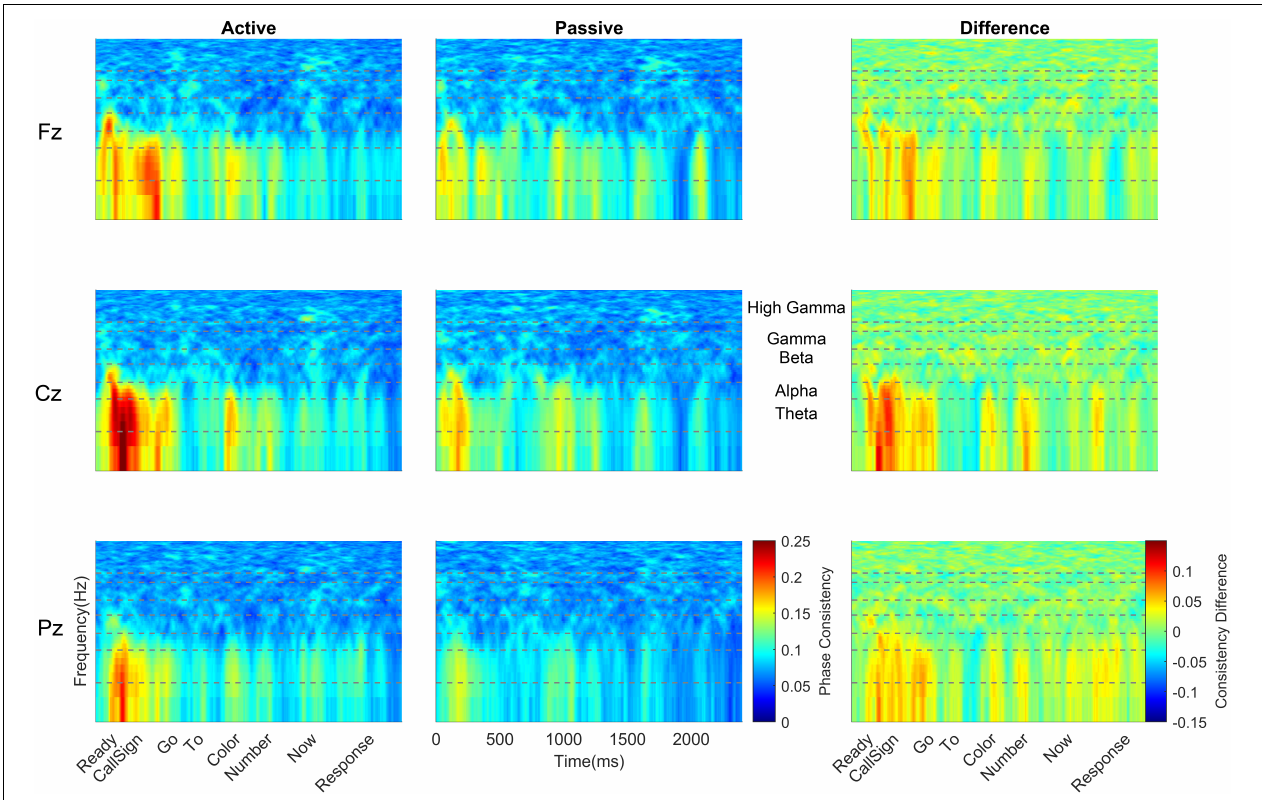
FIGURE 4 | Bilingual cortical phase consistency. Bilingual phase consistency is plotted at Fz (top) , Cz (middle) , and Pz (bottom) for active (left) and passive (center) listening conditions. For these six plots, color represents greater phase consistency, with warmer colors indicating greater consistency and cooler colors representing little to no consistency. The rightmost plots show the difference in phase consistency between active and passive listening conditions, with warmer colors indicating greater consistency during active listening and cooler colors indicating more consistency during passive listening. Compared to monolinguals, bilinguals showed a smaller change in cortical consistency from active to passive listening, driven by a smaller increase in consistency during active listening. However, like monolinguals, bilinguals still had greater cortical consistency during active listening (left column), with consistency highest at the beginning of the sentence and declining as the sentence unfolded. For bilinguals, this effect was greatest at Cz; it did not show the same rostral to caudal distribution seen in monolinguals. Active and difference plots align the cortical consistency with the words in the sentence and passive plots provide an indication of time. Dashed lines on all plots identify the borders of the frequency bands, which are labeled between the passive and difference plots for Cz. To visualize the lower frequencies, all y -axes are plotted on a log